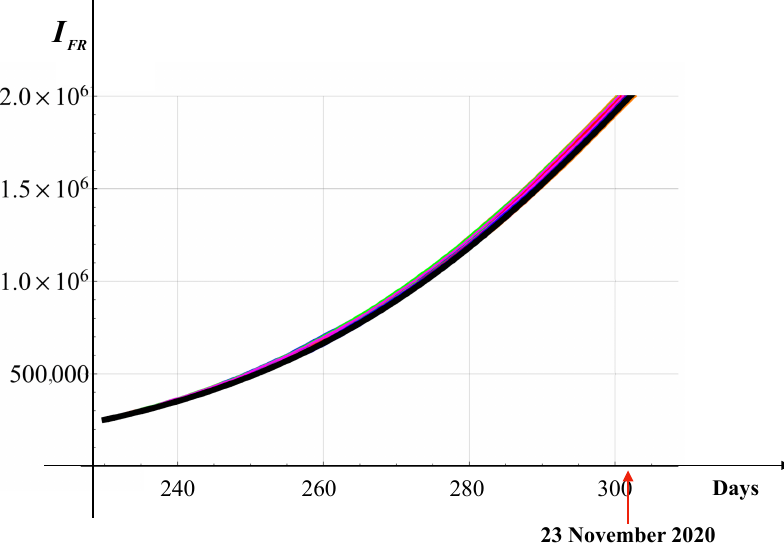
Figure 27. 200 realisations of the stochastic differential equation for France’s second wave. The values of the parameters are those reported in Figure 25. ˜ η = 0.001, which has been estimated according to Equation